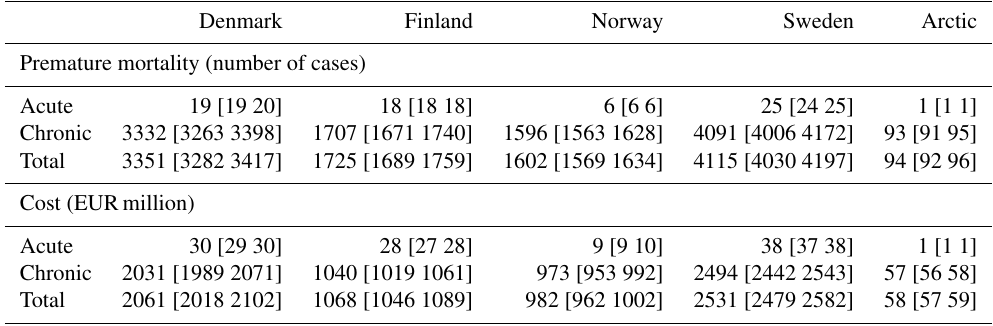
Table 5. Acute and chronic premature death cases in the Nordic countries and the Arctic region (north of 67 ◦ N) in 2015 and the associated costs. The brackets show the 95% confidence interval.